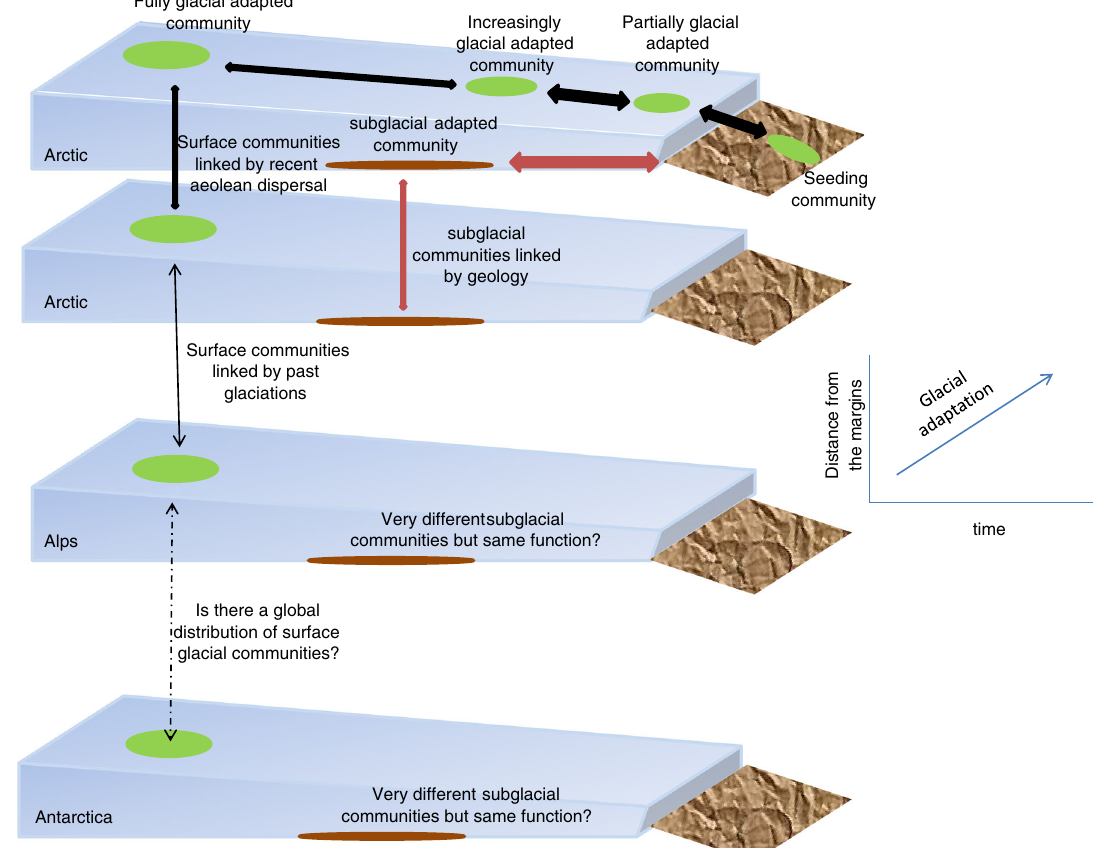
Fig. 3 Pathway for microbial adaptation to glacial conditions. Time, size and spatial distance are all likely to contribute to patterns in microbial communities found in glaciers and ice sheets. Horizontal / diagonal arrows represent selection of microbial communities from glacial margins that are increasingly adapted to glacial survival at the interior of the ice. Vertical arrows represent potential links between different glaciers at different spatial and time